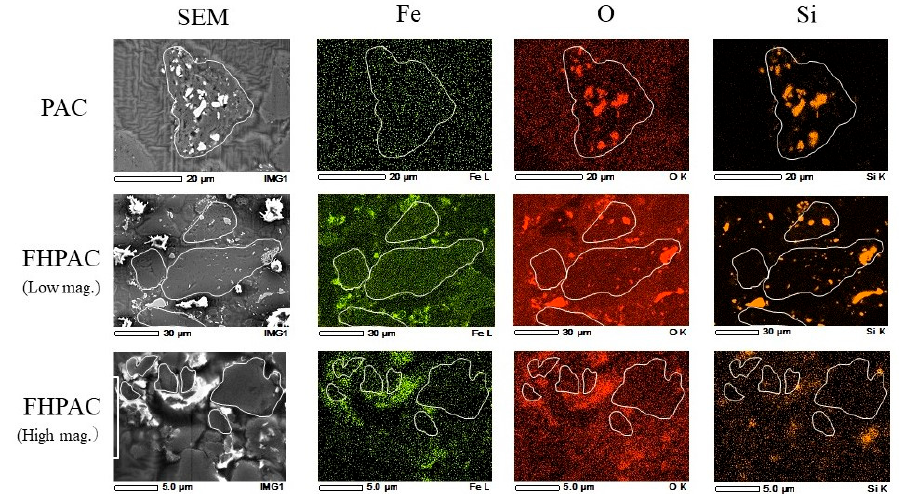
Figure 2. SEM-EDS images with iron, oxygen, and silica mapping of bare PAC and FHPAC. Particle surface areas and porosities were investigated by nitrogen adsorption–desorption isotherms (Table 1). The adsorption–desorption pattern detected for both materials obeyed the hysteresis loop type H3 according to the IUPAC classification. The PAC and FHPAC surface areas (S BET ) were determined to be 647 and 337 m 2 /g, respectively, using the BET surface area method. The PAC and FHPAC pore volumes were calculated to be 0.870 and 0.395 cm 3 /g, respectively, using the BJH method. The PAC and FHPAC pore sizes were similar with a diameter of 3.8 nm, calculated by the BJH method. The S BET of FHPAC was 1.92 times smaller than that of virgin PAC; the majority of this decrease was in the microporous surface area (S mic ), which decreased 2.49 times after impregnation. The total pore volume (V t ) and micropore volume (V mic ) of FHPAC also had similar decreases compared to virgin PAC. On the contrary, the pore sizes of the modified FHPAC and bare PAC remained almost the same. These results suggest that the reductions in specific surface area and pore volume were caused by the impregnation of iron on the surface of PAC particles [23], but iron impregnation did not block pore mouths or channels or change the pore structure to a significant extent